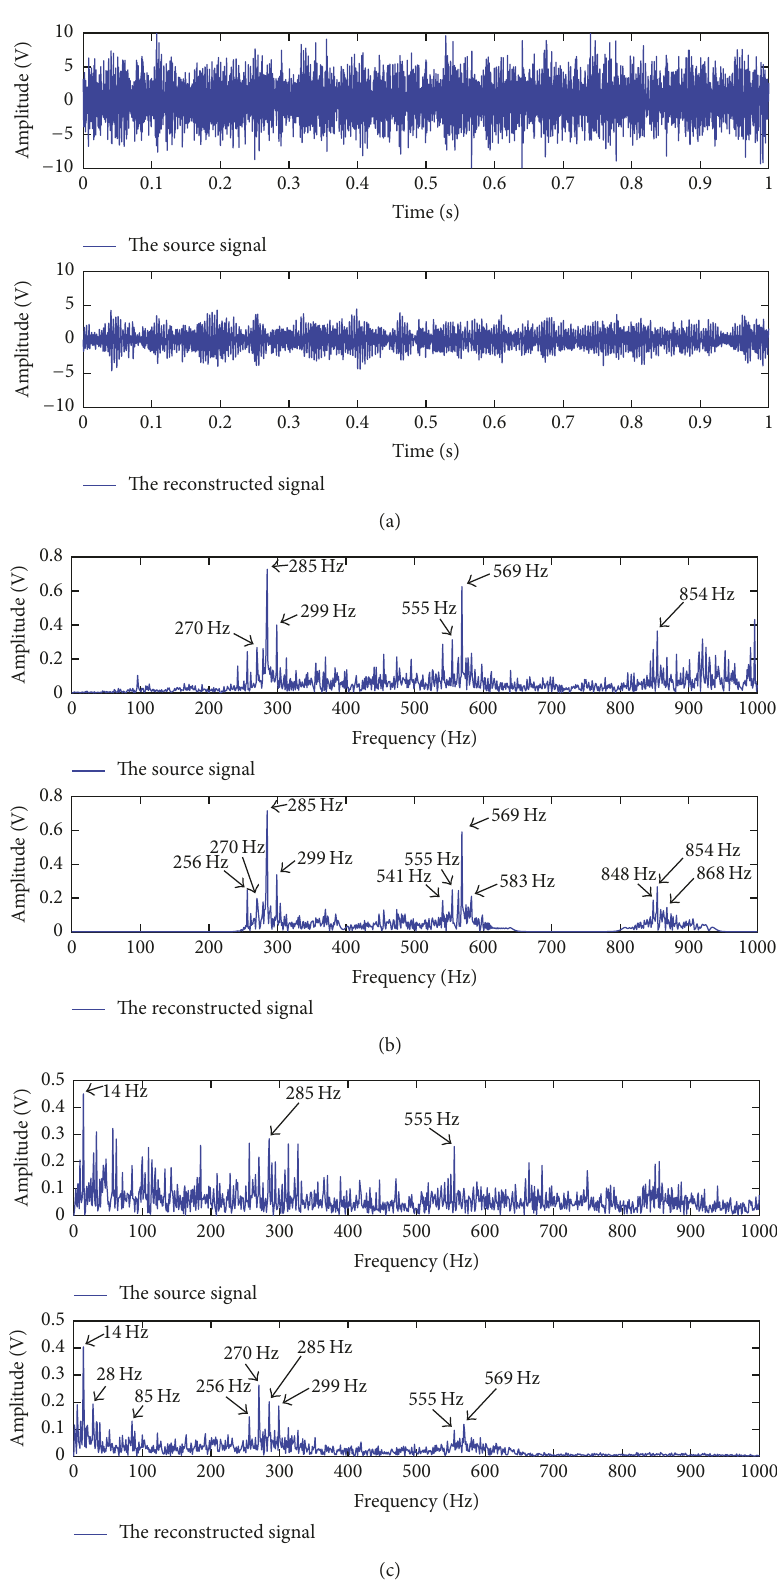
Figure 9: Gear fault signal analysis results from the EOMP method: (a) waveform of the source signal and waveform of the reconstructed signal, (b) FFT spectrum of the source signal and FFT spectrum of the reconstructed signal, and (c) Hilbert spectrum of the source signal and Hilbert spectrum of the reconstructed